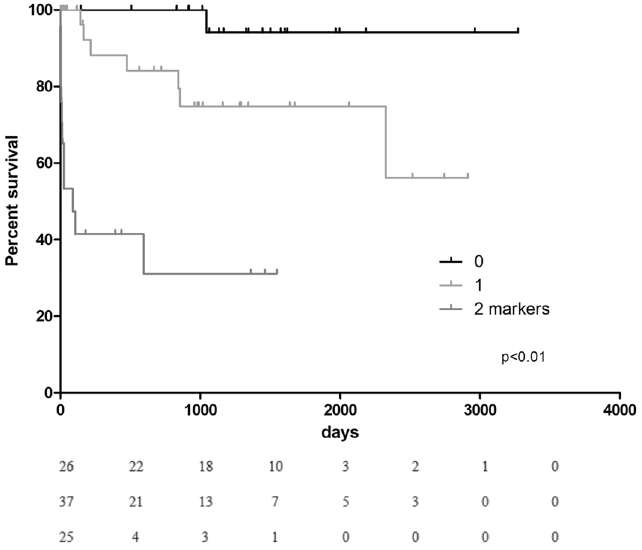
Figure 3. Kaplan Meier curves, showing survival rates in patients with levels of CEA and CA-19.9 over median values or